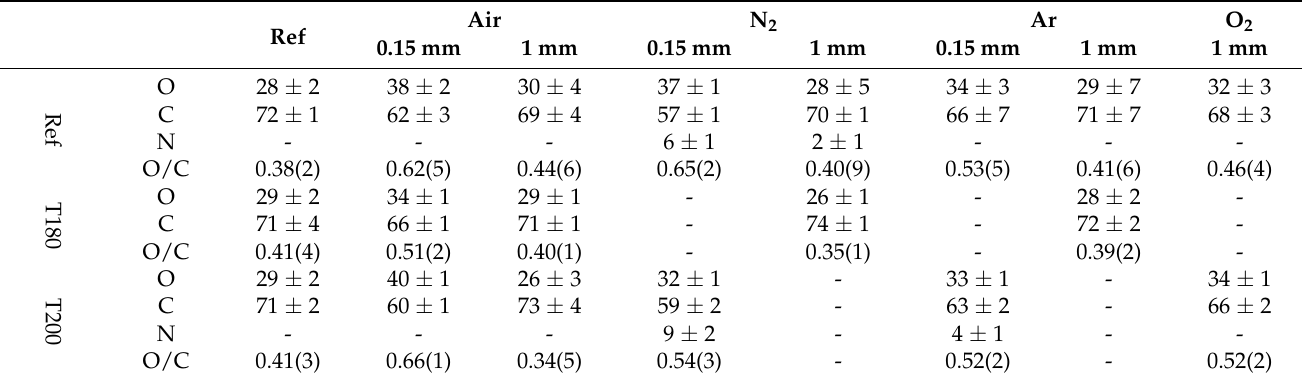
Table 1. Oxygen and carbon atomic percentage and O/C ratio obtained from XPS spectra for various gases and distances from the electrode. Data are in [%], except for O/C, which is